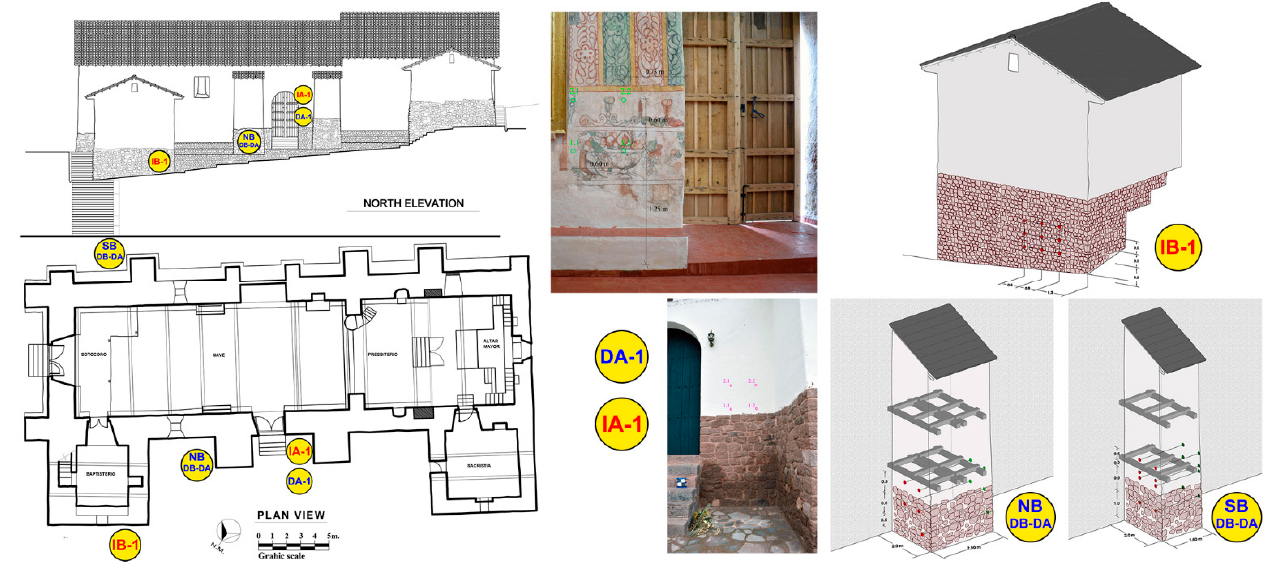
Figure 12. Retrofitted state of the Church of Kuñotambo: location of direct and indirect sonic tests in adobe and rubble stone masonry during the December 2019 field campaign (after